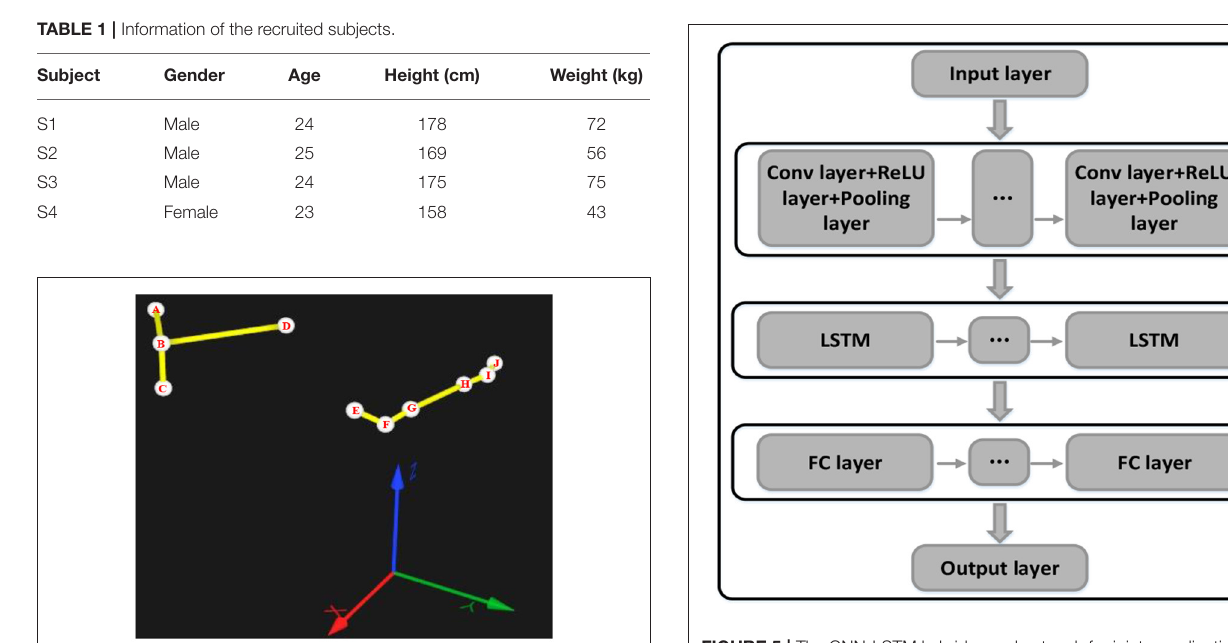
FIGURE 5 | The CNN-LSTM hybrid neural network for joint coordination relationship